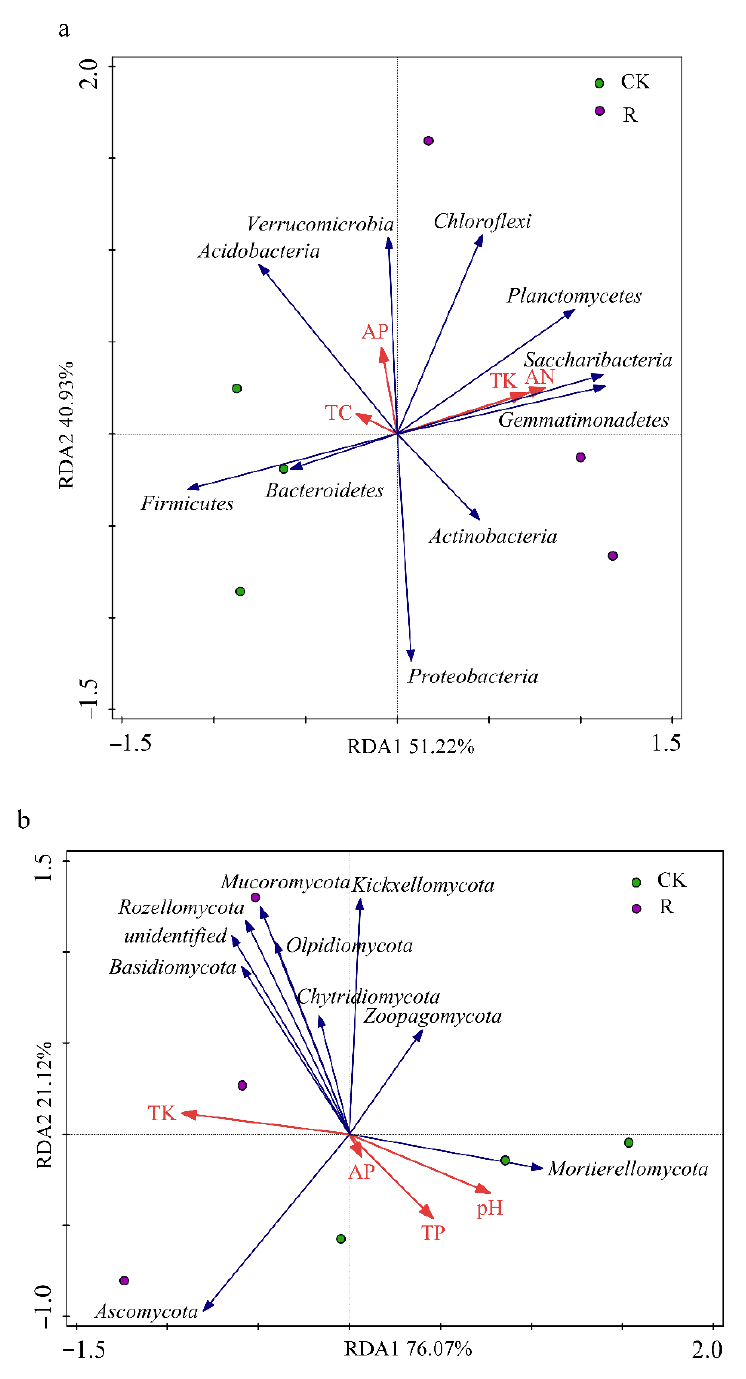
Figure 3. Redundancy analysis (RDA) between microbial communities and physicochemical charac- teristics at the 5 th post-returning stage (( a ) for bacteria, ( b ) for fungi). CK, the non-vegetable residue treatment; R, the vegetable residue